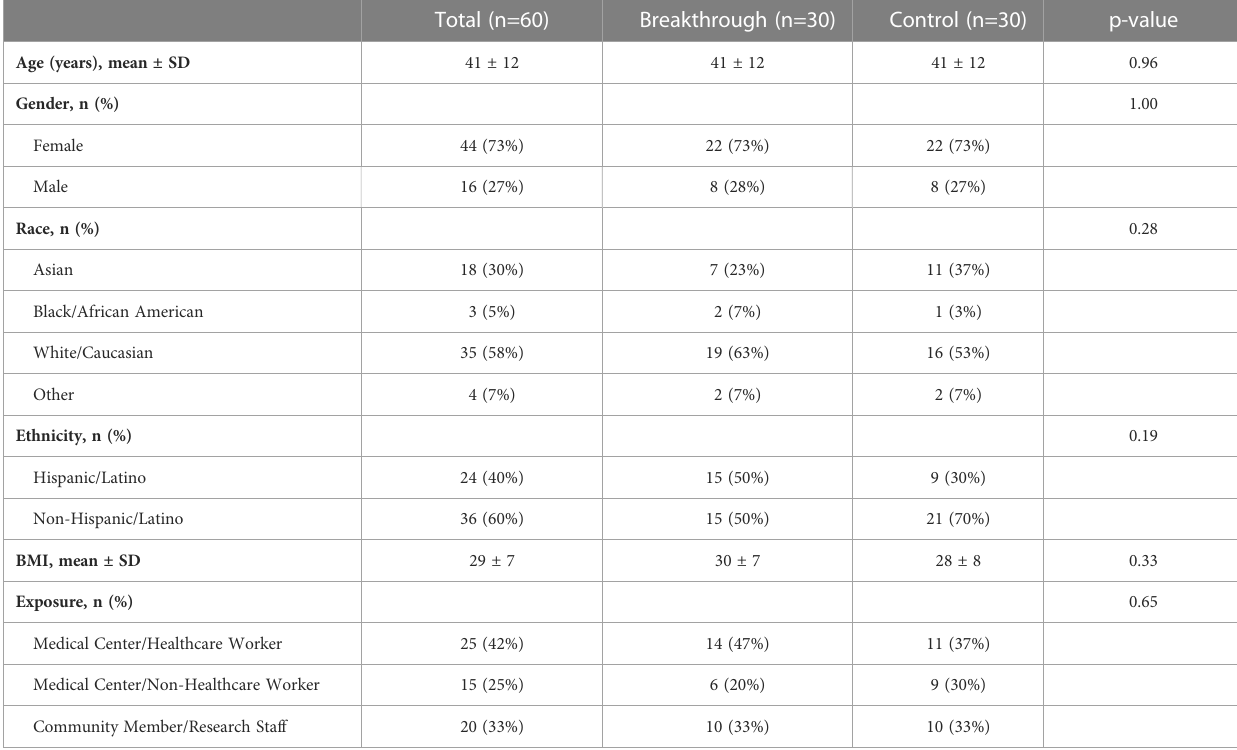
TABLE 4 Breakthrough and vaccinated control participant demographic